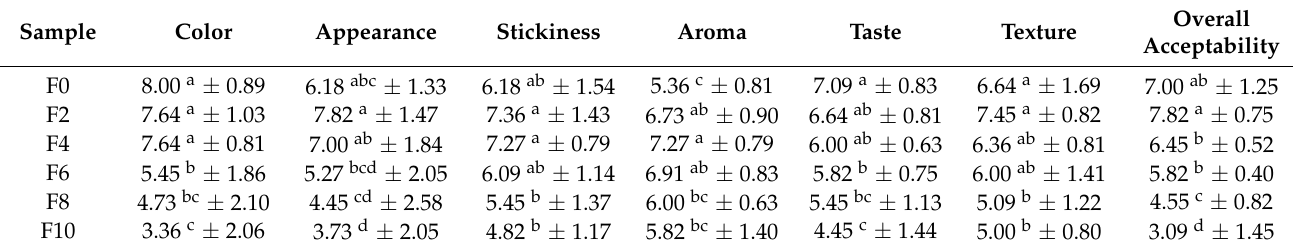
Table 8. Sensory acceptability of F0 and